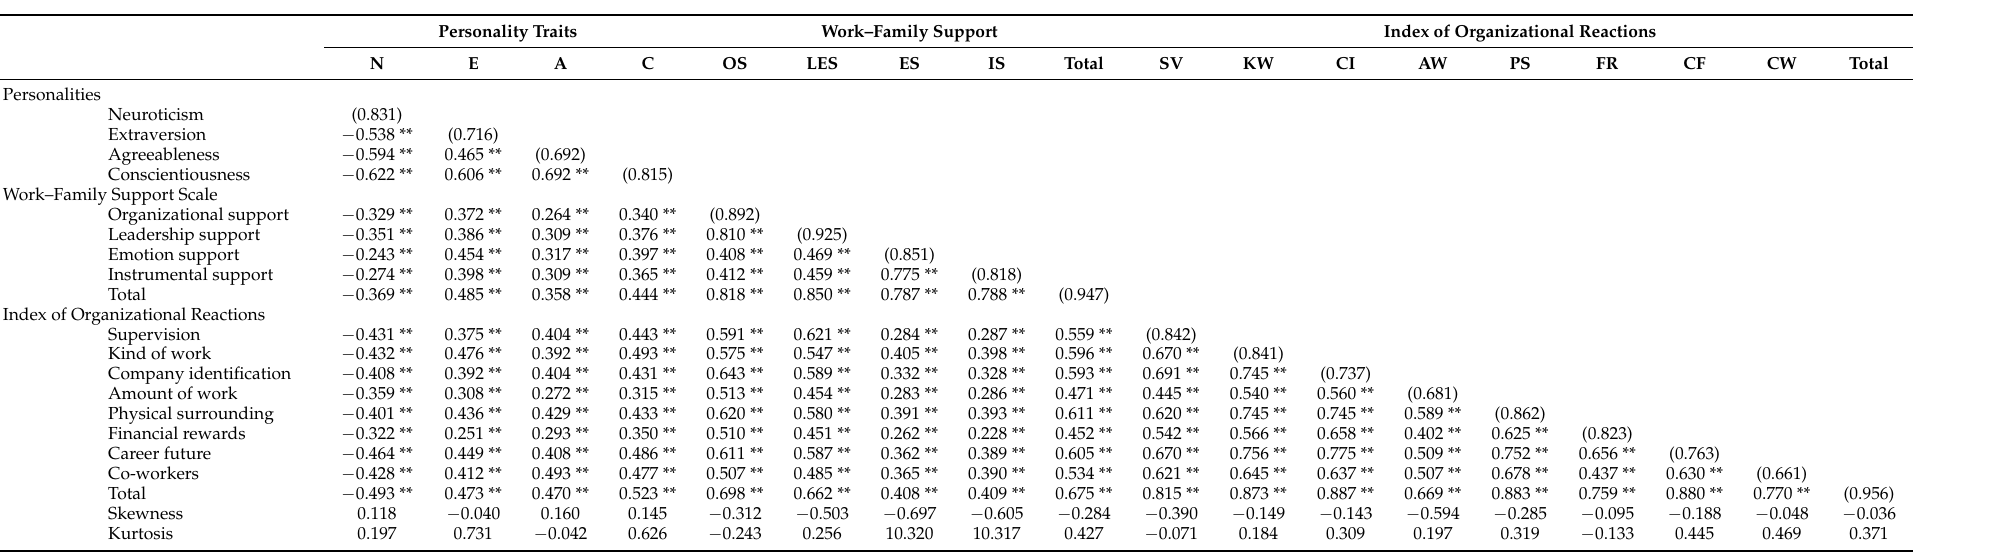
Table 3. Correlation matrix between main